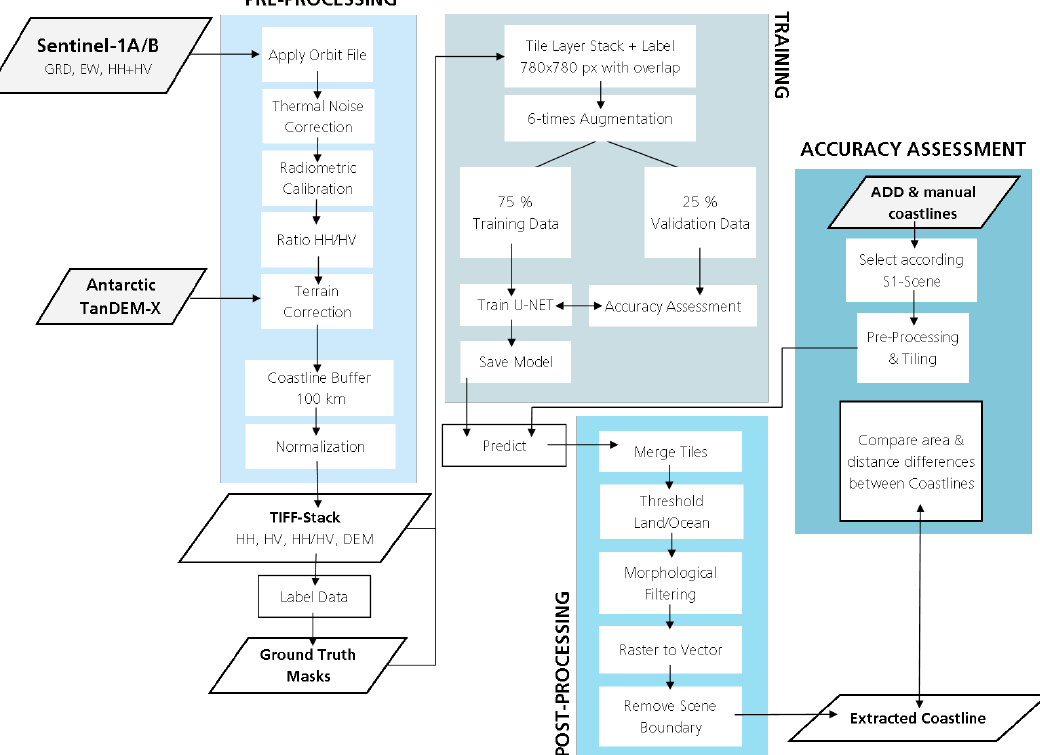
Figure 4. Flowchart of the processing chain to extract Antarctic glacier and ice shelf fronts separated in a per-processing, training, and post-processing block as well as the final accuracy assessment. Abbreviations: DEM: digital elevation model, S1: Sentinel-1, GRD EW: Extra wide swath Level-1 ground range detected S1